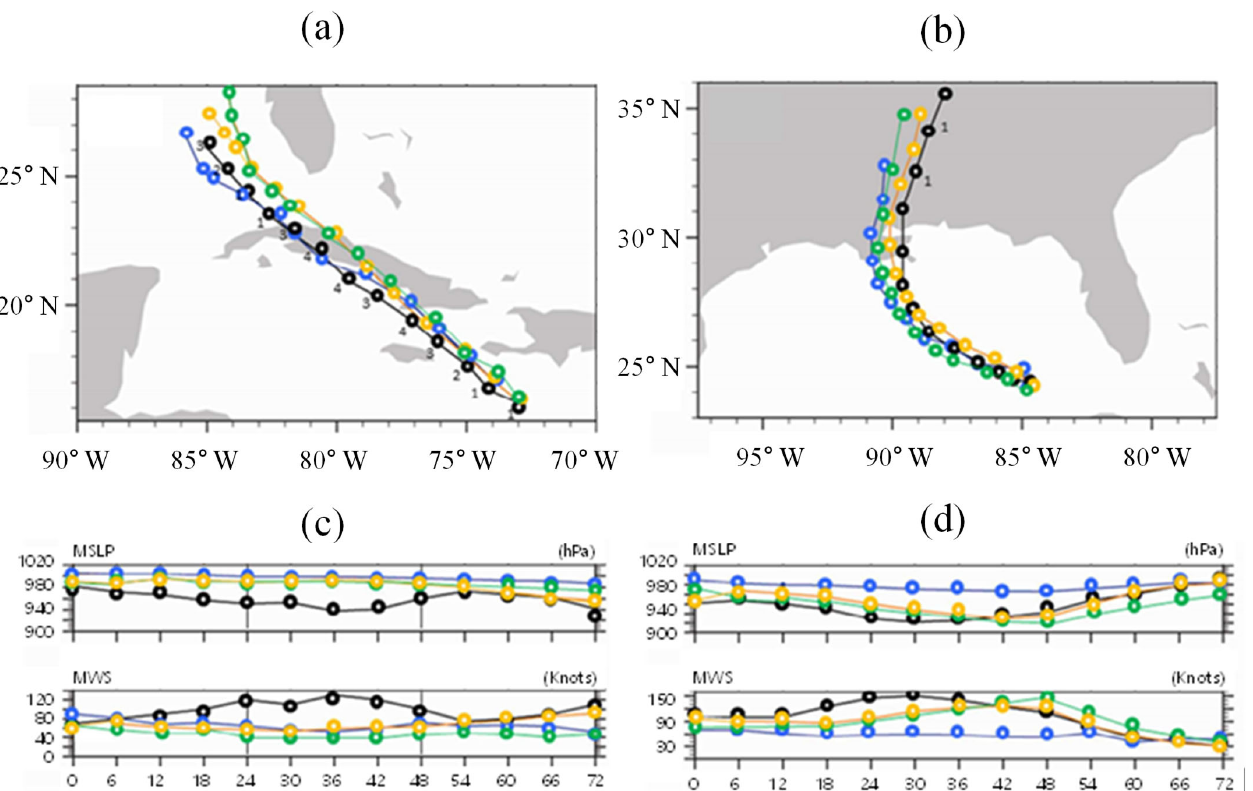
Figure 6. The 72-h forecast track ( a , b ) and intensity ( c , d ) for Hurricane Dennis ( a , c ) and Hurricane Katrina ( b , d ), according to the best-analyzed observation (Best), Global Forecasting System (GFS), Hurricane Research System (HRS), and HRS coupled with the Hurricane Local Analysis Prediction System (HRS/HLAPS). The black, blue, green, and yellow colors represent the Best, GFS, HRS, and HRS/HLAPS models, respectively. Symbols are plotted every 6 h.